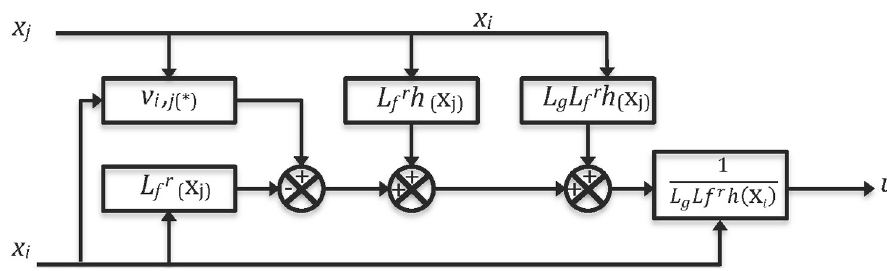
Fig 1. Block diagram of model-matching control.